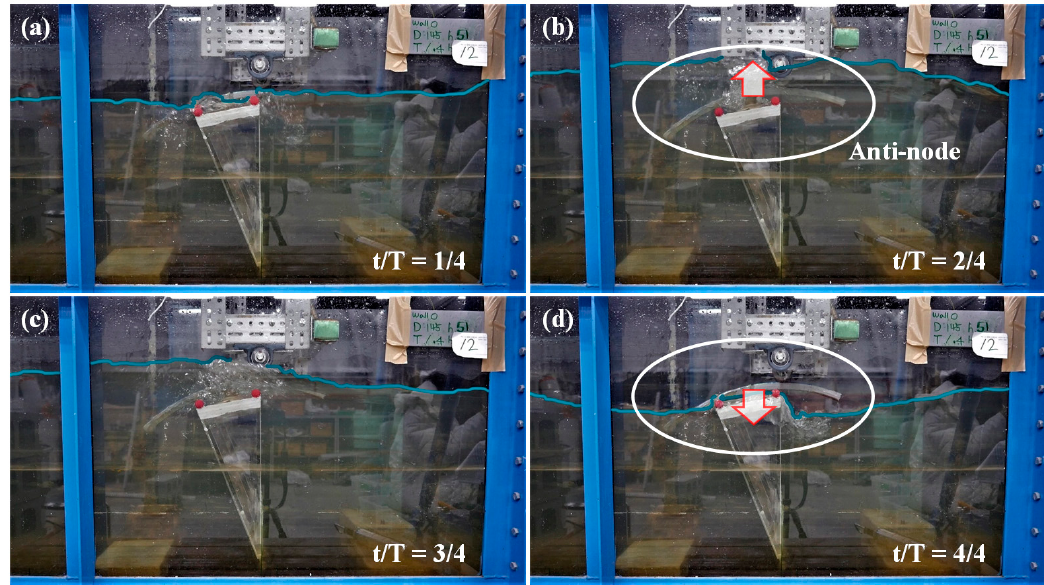
Figure 11. Screenshots for pattern D for the case of D = 1.45 m, h = 0.51 m, T = 1.4 s, and H i = 0.12 m at ( a ) t / T = 1 / 4, ( b ) t / T = 2 / 4, ( c ) t / T = 3 / 4, and ( d ) t / T = 4 / 4. D / L was 0.56. The blue solid line denotes the water surface.